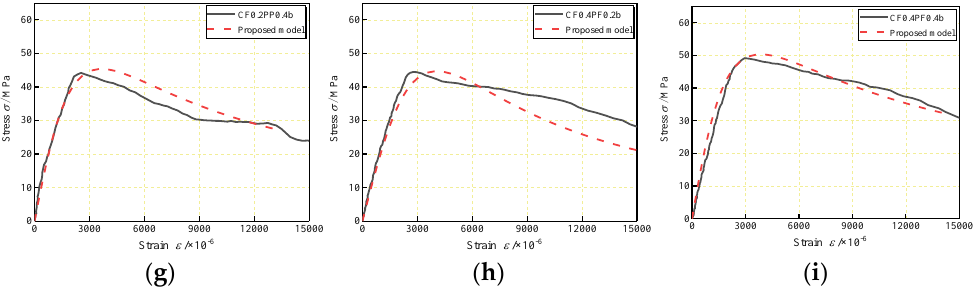
Figure 12. Comparison of calculated complete stress–strain curves for: ( a ) Plain–b; ( b ) CF0.2b; ( c ) CF0.4b; ( d ) PF0.2b; ( e ) PF0.4b; ( f ) CF0.2PF0.2b; ( g ) CF0.2PF0.4b; ( h ) CF0.4PF0.2b; ( i )